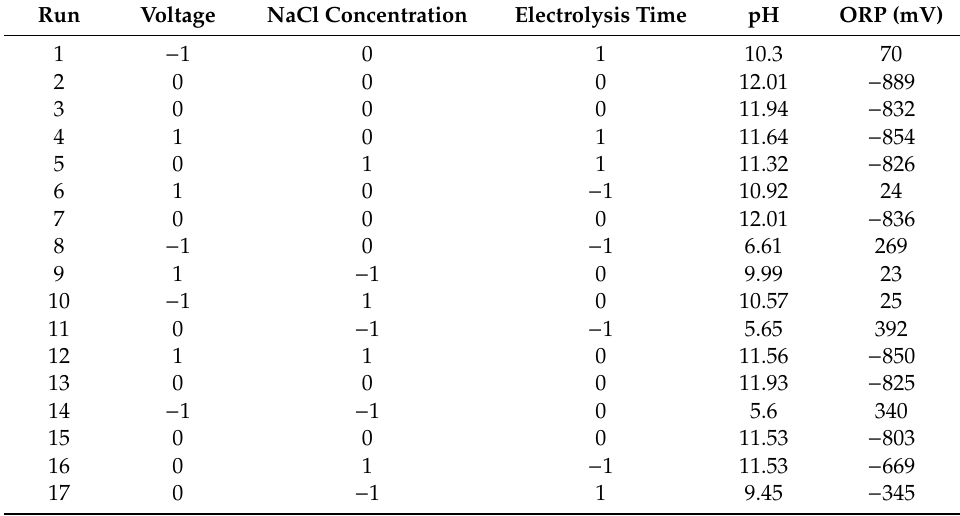
Table 7. Box–Behnken response surface design arrangement and response for alkaline electrolyzed water (AlEW).